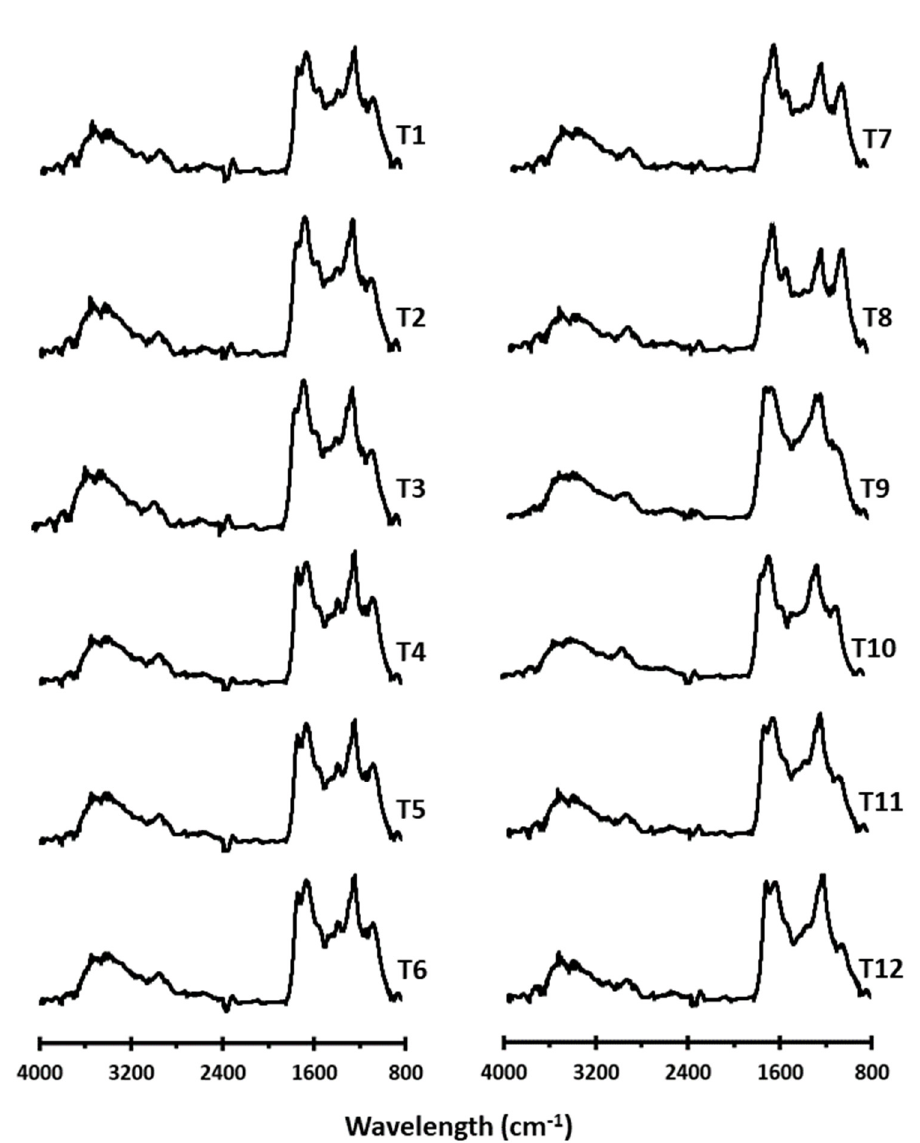
Figure 3. Attenuated total reflectance–Fourier transform infrared (ATR-FTIR) spectra of humic acids from soils under different organic treatments. Tn—treatment number: T1—farmyard manure (FYM, with field age of 0.5 years), T2—brown coal waste (BCW, 0.5 years), T3—biochar (BIO, 0.5 years),